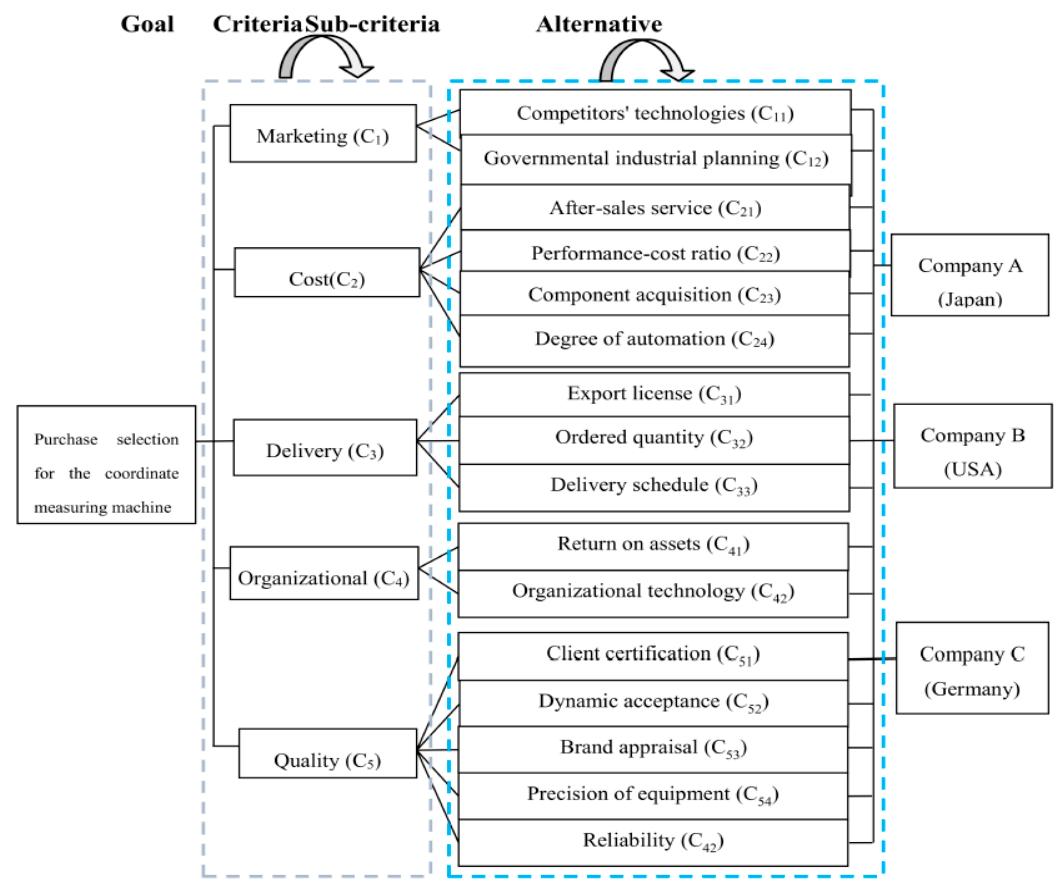
Figure 5. Hierarchical network for CBPPM supplier selection.